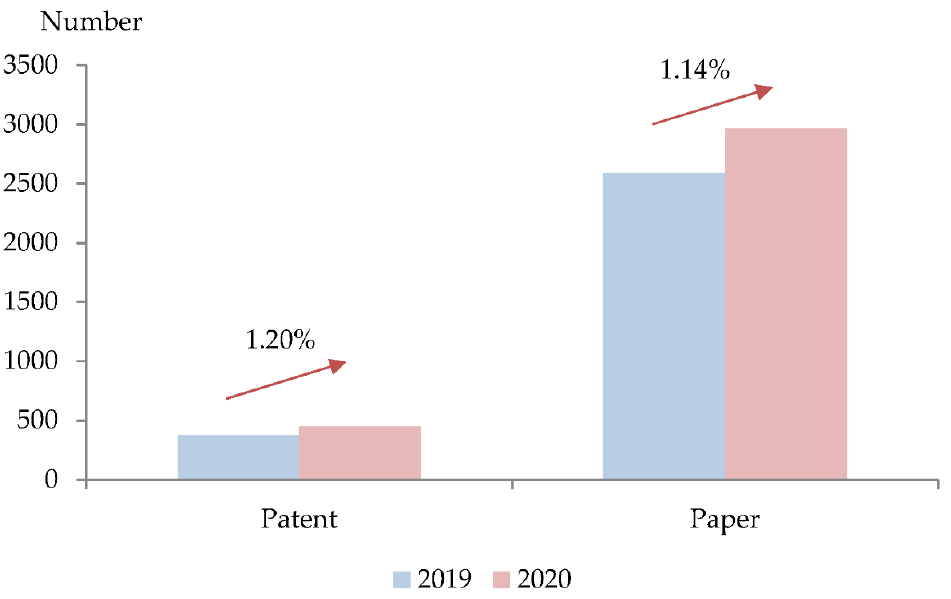
Figure 4. Number of patents and papers in 2019 and 2020.